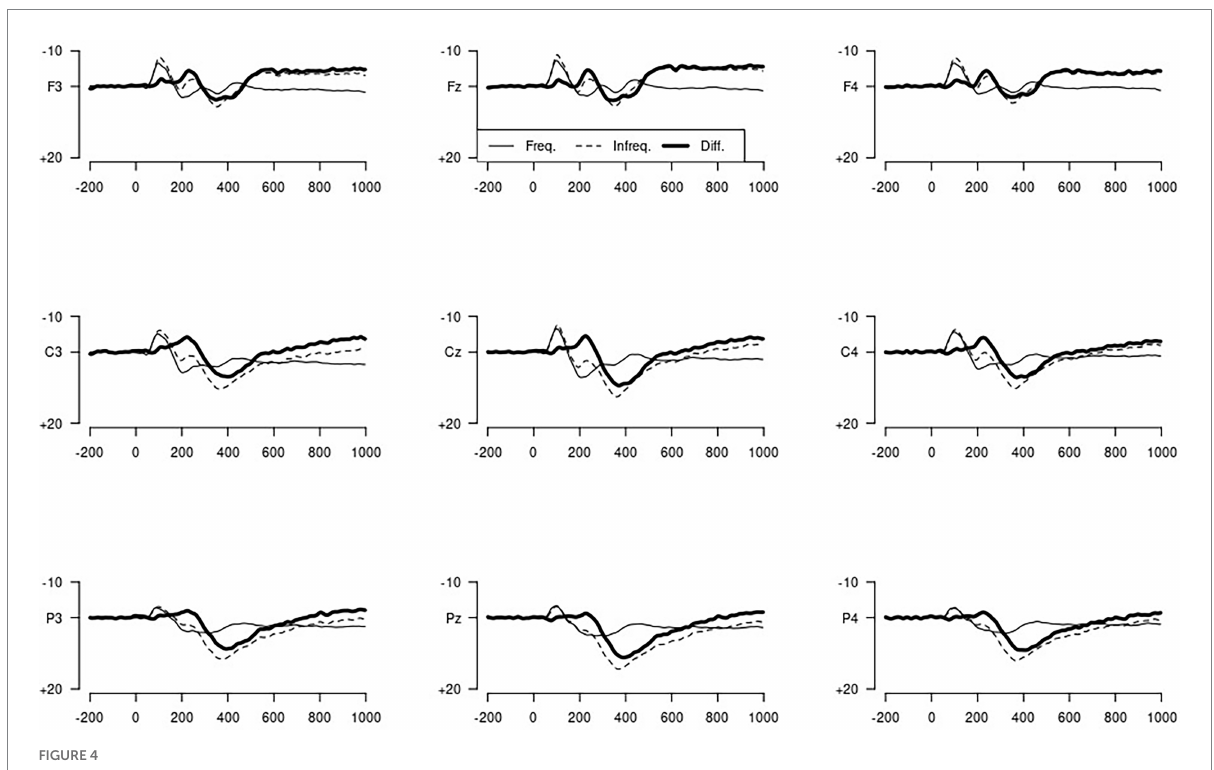
FIGURE 4 Overview of event-related potentials for Standard and target